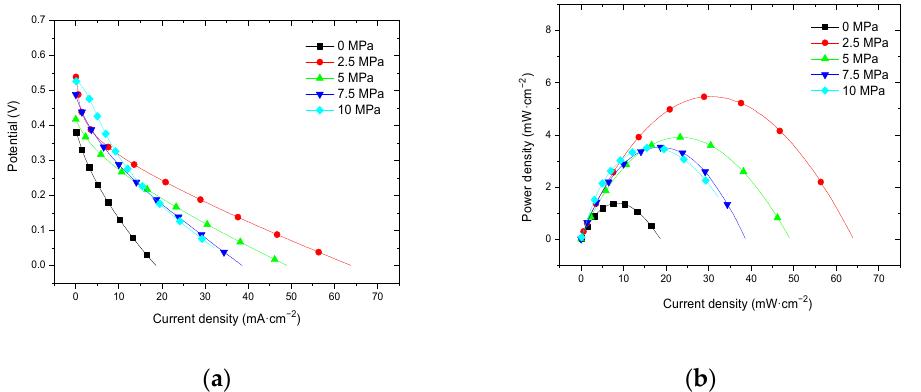
Figure 9. The effect of hot-pressing pressure on the performance of titanium mesh-based MEA at room temperature with air self-breathing environment. ( a ) Curve between current density and voltage; ( b ) curve between current density and power density.